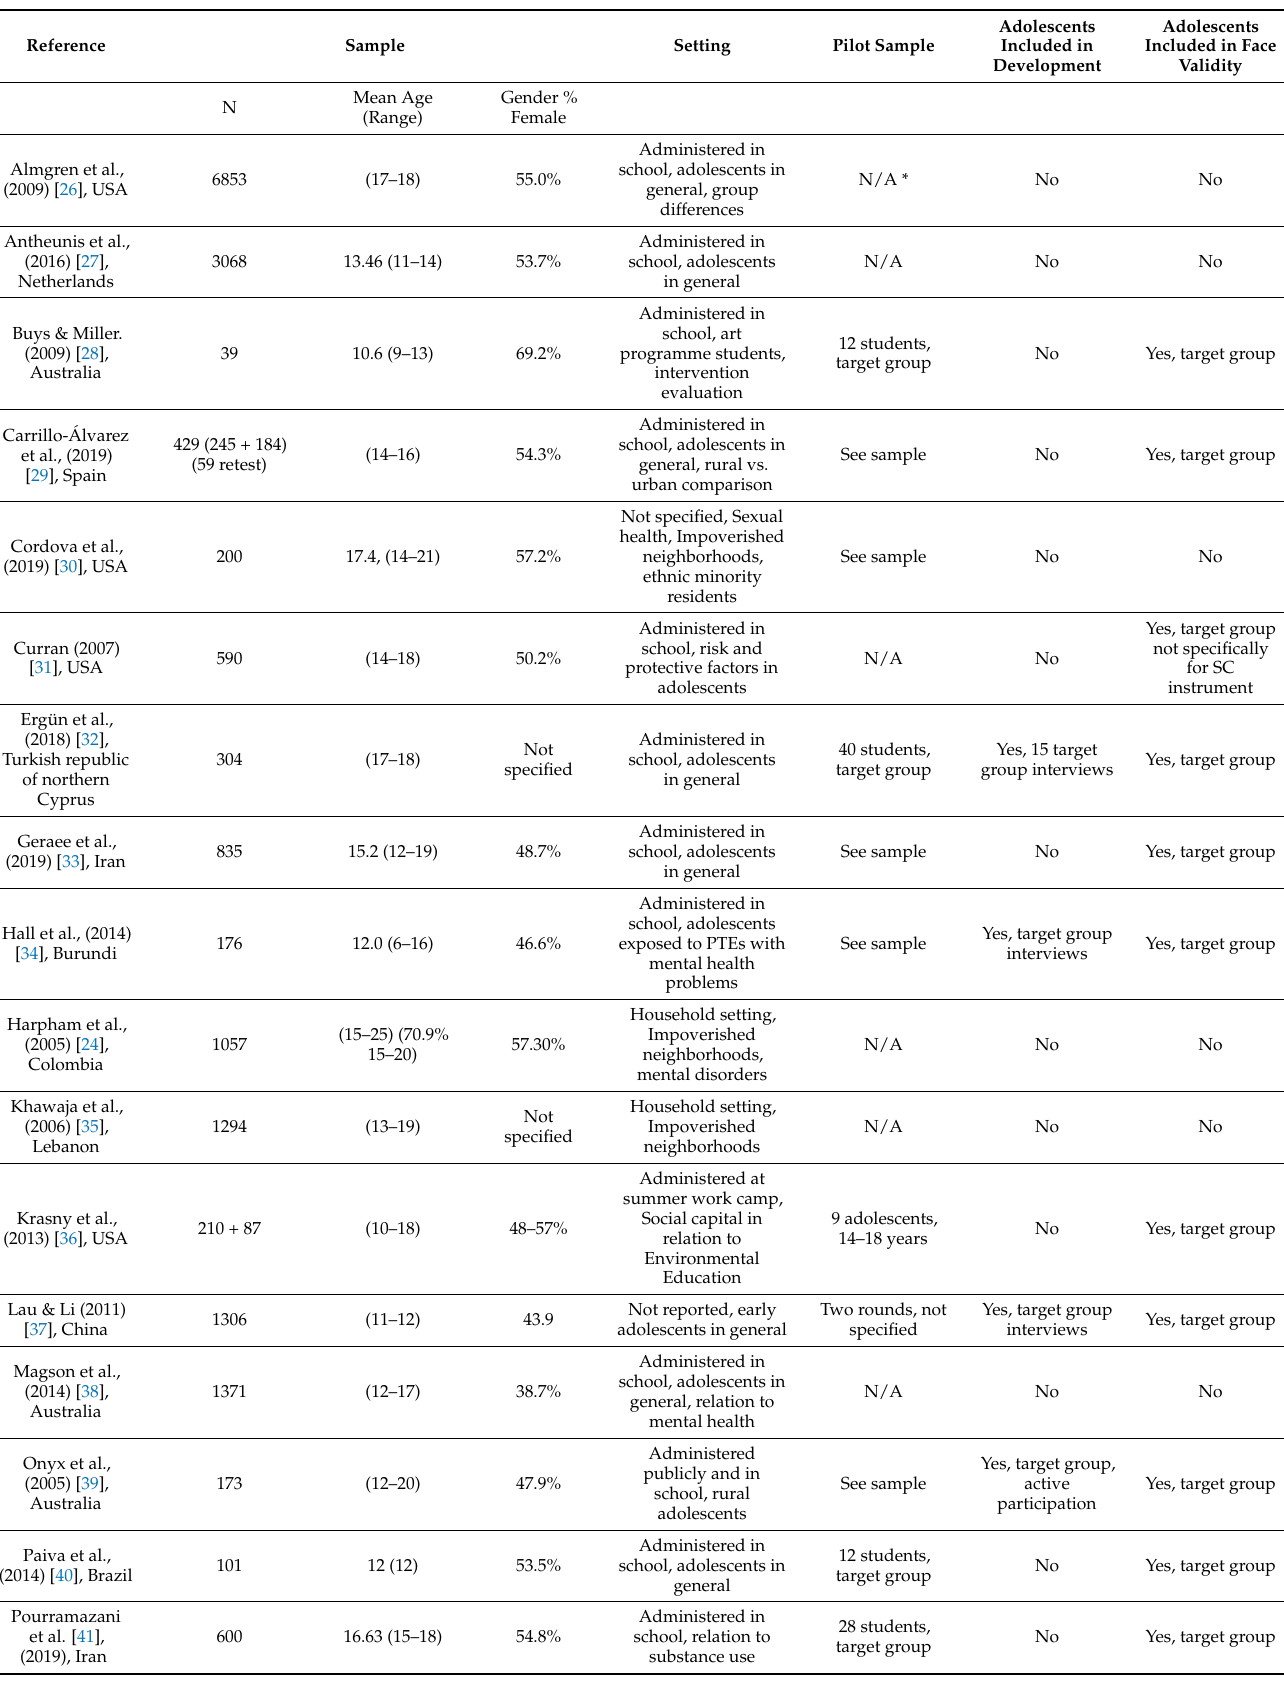
Table 3. Sample, setting and involvement of adolescents in development and